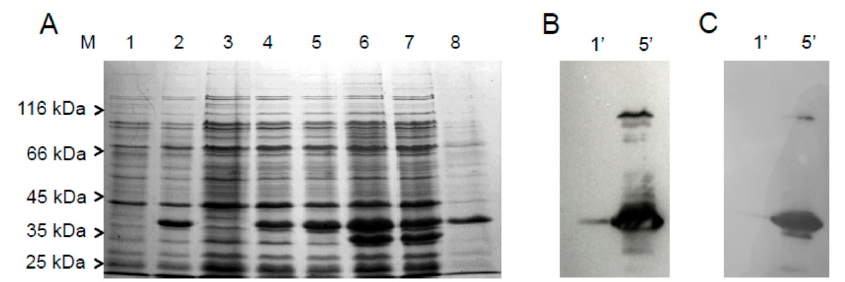
Figure 2. Over-expression and identification of recombinant hFADS6. ( A ) Proteins were separated by SDS–PAGE (Sodium Dodecylsulfate-Polyacrylamide Gel Electrophoresis) on 12% T polyacrylamide gel and stained with Coomassie Blue. Lane M: molecular mass markers: beta-galactosidase (116 kDa), bovine serum albumin (BSA) (66 kDa), ovalbumin (45 kDa), lactate dehydrogenase (35 kDa), restriction endonuclease Bsp98I (25 kDa); lane 1, non-induced cell lysate after 2 h of growth (6 µ g); lane 2, cell lysate after 2 h of induction (8 µ g); lane 3, soluble fraction of non-induced cell lysate after 2 h of growth (10 µ g); lanes 4–6, soluble fractions of cell lysate after 2 h, 4 h and 8 h of 0.1 mM isopropyl β - D -1-thiogalactopyranoside (IPTG) induction at 28 ◦ C, (12, 14 and 15 µ g) respectively; lane 7, soluble fractions of cell lysate after 8 h of 0.1 mM IPTG induction at 20 ◦ C (13 µ g); lane 8, insoluble fraction of cell lysate after 4 h of 0.1 mM IPTG induction at 28 ◦ C (7 µ g); ( B ) Immunoblotting of hFADS6: lanes 1 (cid:48) and 5 (cid:48) , immunodetection on the same protein fractions as in ( A ) with anti-FADS antiserum (1:2500); ( C ) lanes 1 (cid:48) and 5 (cid:48) , immunodetection on the same protein fractions as in ( A ) with anti-His antibody (1:40,000). The molecular mass markers in ( B , C ) were as in ( A ). Spectrophotometric analysis of purified fraction 5 (Figure 3B) as well as of fractions 4, 6 and